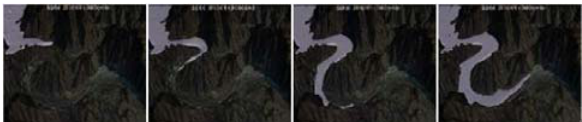
Figure 6. The dynamic visualization of a dam-break flood spatio-temporal